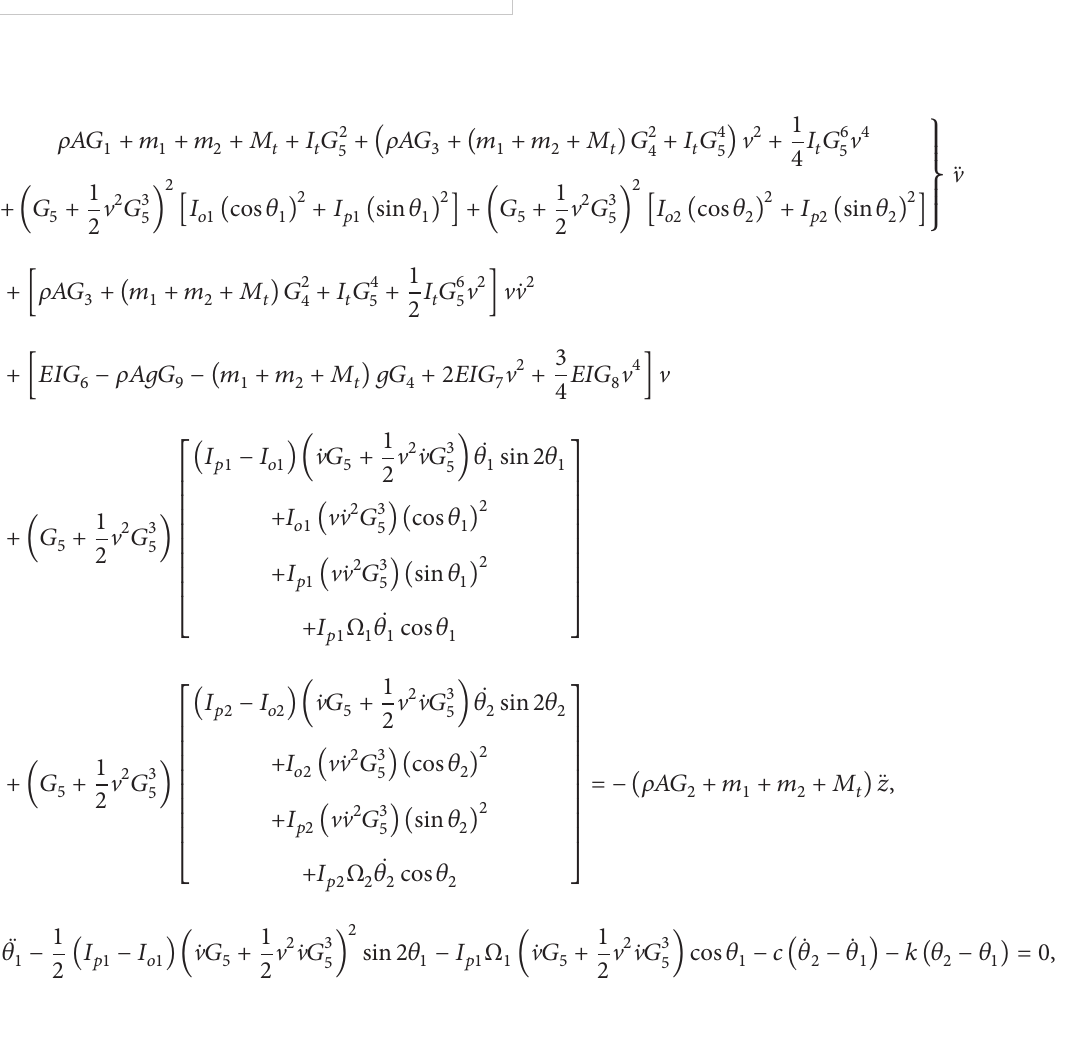
The dissipation function 𝐷 takes the form